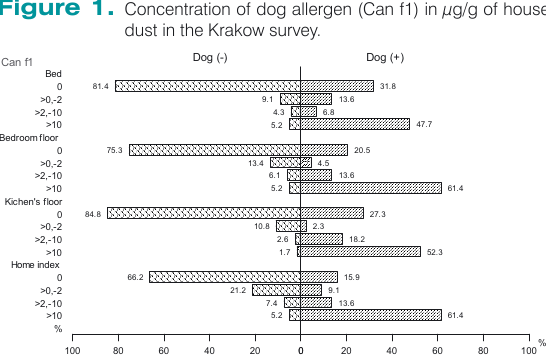
Figure 1. Concentration of dog allergen (Can f1) in µg/g of house dust in the Krakow survey.